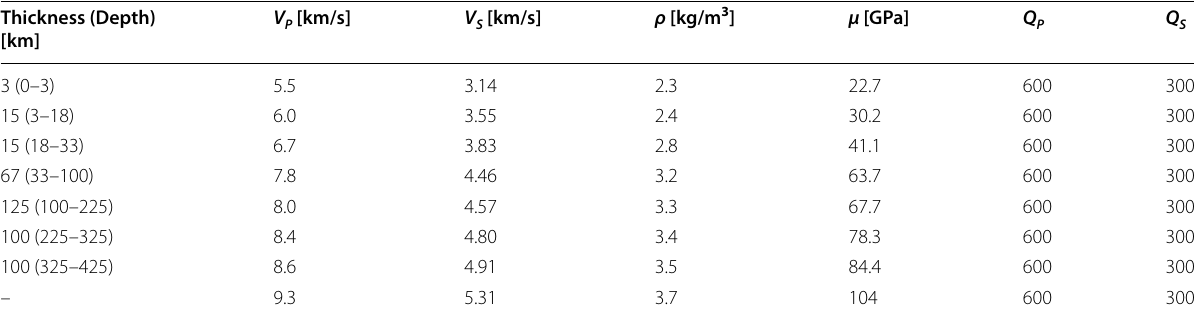
Table 2 F-net 1D velocity model. The physical parameters were referred from Kubo et al. (2002) Thickness (Depth)